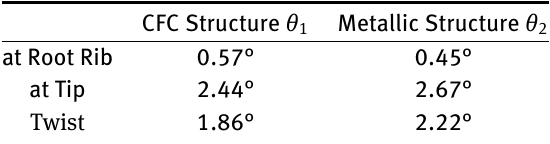
Table 3: Angle of Twist